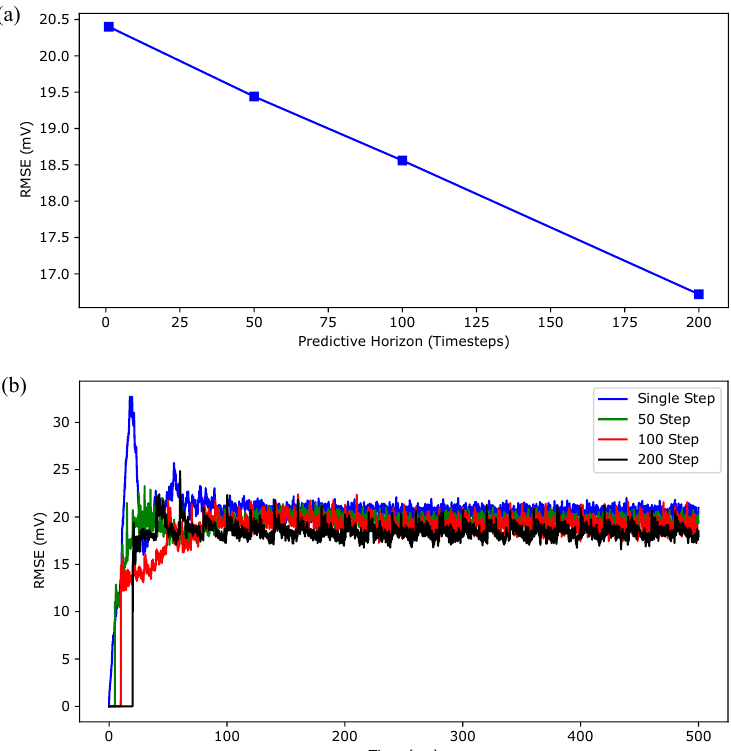
Figure 10. The effect of the prediction horizon of the deep LSTM neural network on the accuracy of irregular bursting dynamics prediction. ( a ) shows the time-averaged root mean squared error (RMSE) versus predictive horizon of the LSTM network ( N p = 1,50,100,200) for the simulation results shown in Figure 9. ( b ) shows the RMSE versus simulation time for 5000 independent realizations, drawn from the predicted membrane potential trajectories of 50 randomly selected stimulating currents from a Uniform distribution U ( 0.79,2.3 ) and 100 random initial conditions for each stimulating